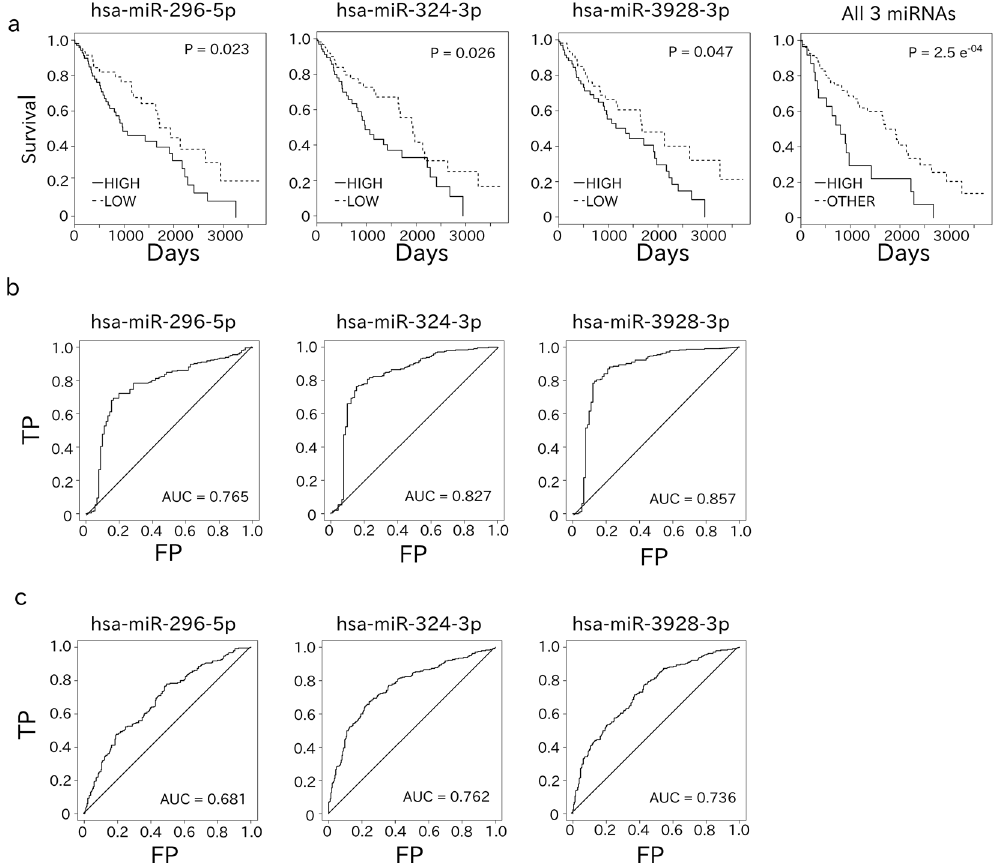
Figure 2. Survival probability and ROC curve for Sq patients according to miRNA expression. ( a ) Kaplan- Meier curve showing that higher miRNA expression was associated with poor prognoses. P-values were calculated by log-rank test. ( b , c ) The ROC curve indicates that higher expression of individual miRNAs is a good indicator to separate Sq from normal tissues (N) ( b ) or Sq from Ad ( c